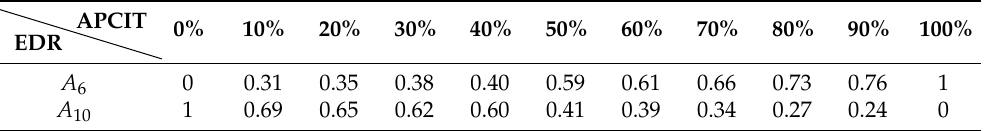
Table 4. EDR result of Move Mode 2.